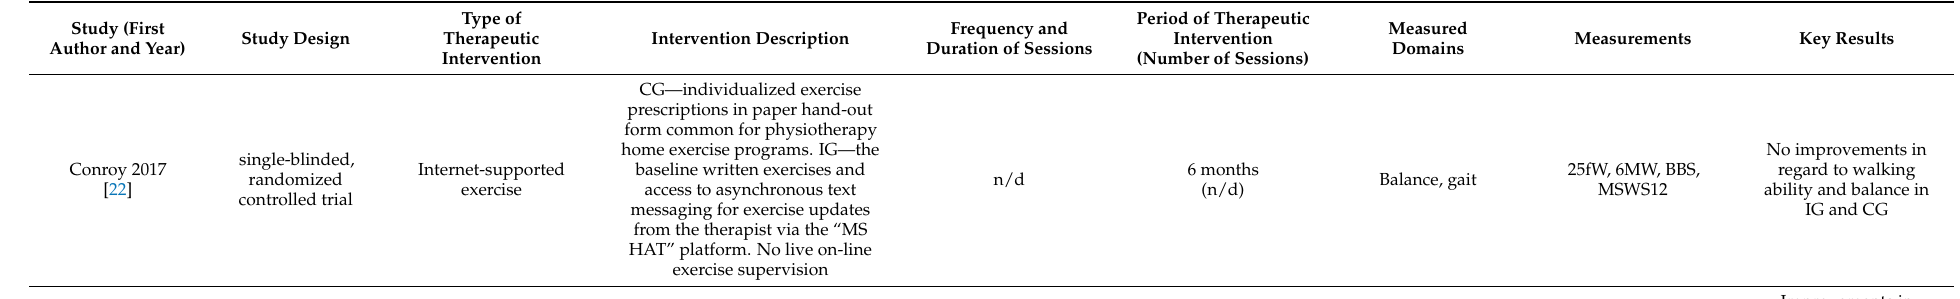
Table 5. Characteristics of studies analyzing the effect of new technologies on gait and balance in MS